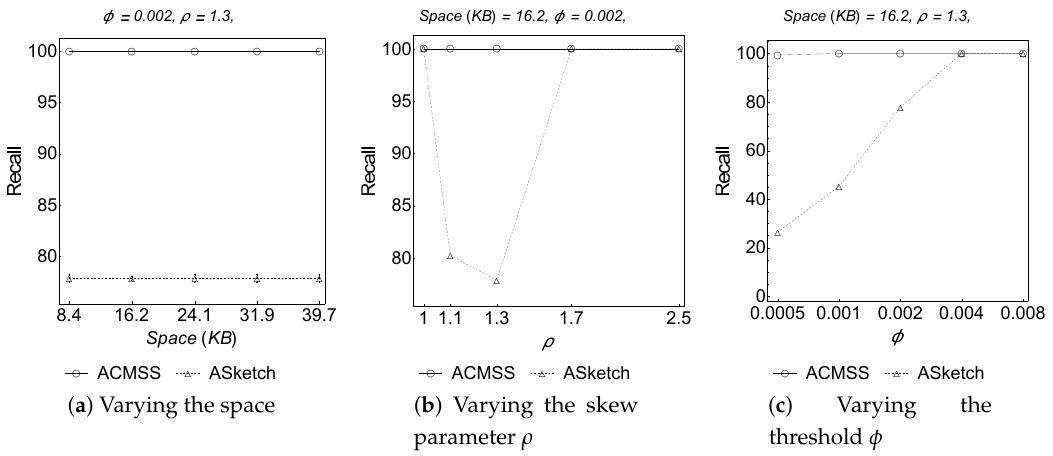
Figure 4. Accuracy of the algorithms: Recall.